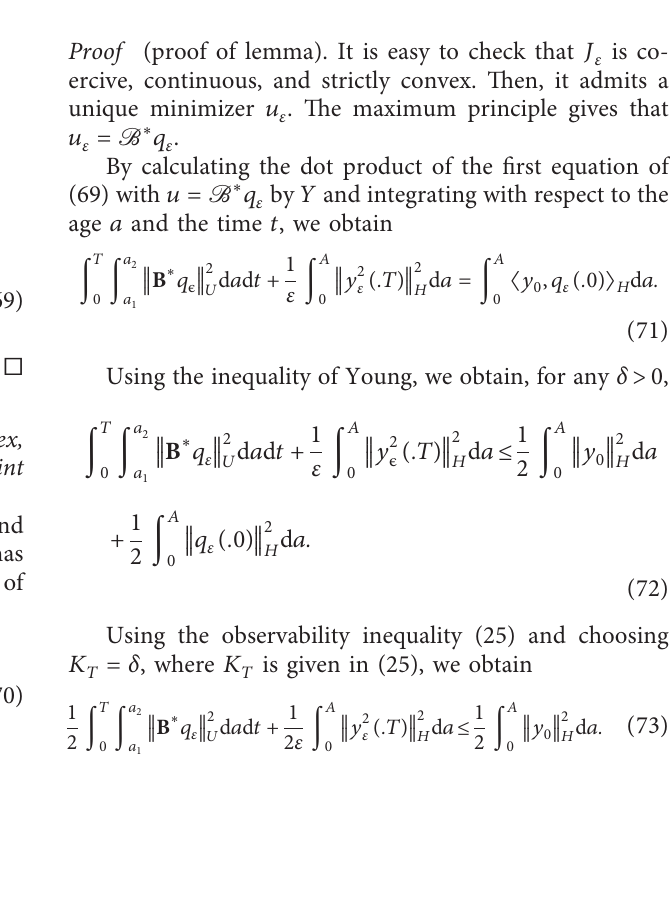
Figure 3: The backward characteristics starting from ( a, 0 ) with a ∈ ( a condition β ( a ) q ( 0 , t ) , and then enters the observation domain. More precisely, in addition to the observation time T backward characteristics need at most A − a + a maximum T time to enter the observation domain. Thus, we need in all, at least, T � A − a 0 1 inequality. So, with the conditions T > A − a get renewed by the renewal condition β ( a ) q ( 0 , t ) in t ∈ ( 0 ,T − η ) and enter the observation